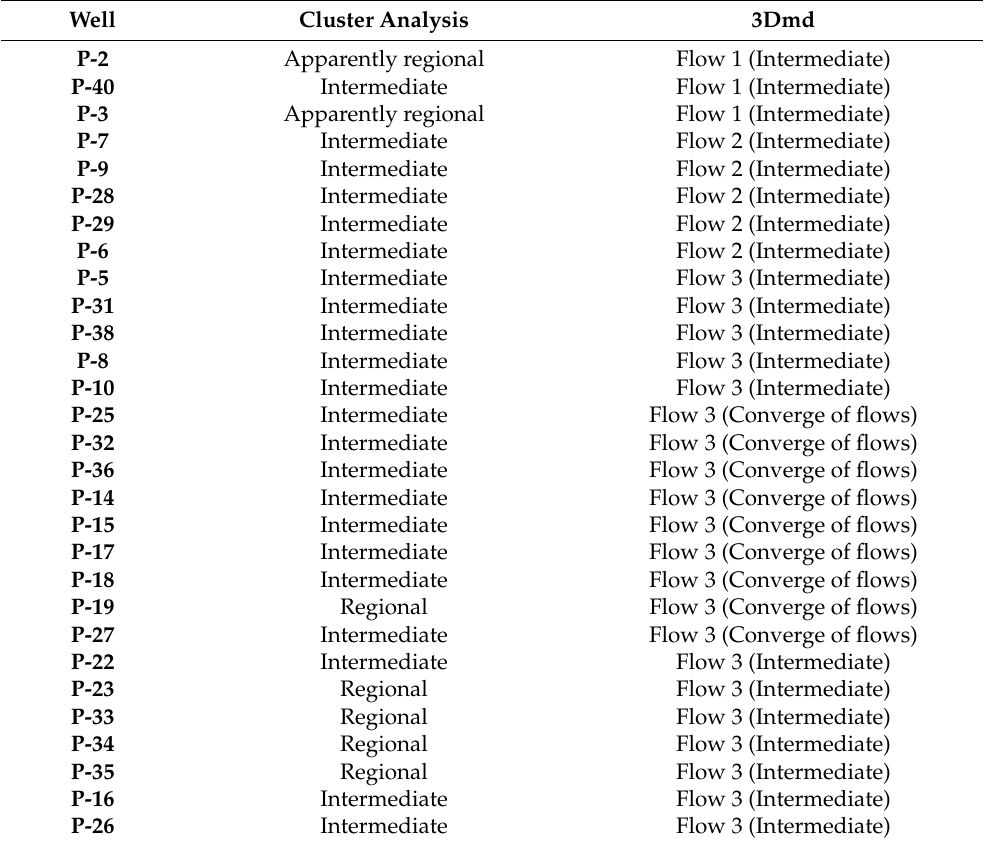
Table 5. Comparison of the identification of flow systems by cluster analysis and 3D multivariate data